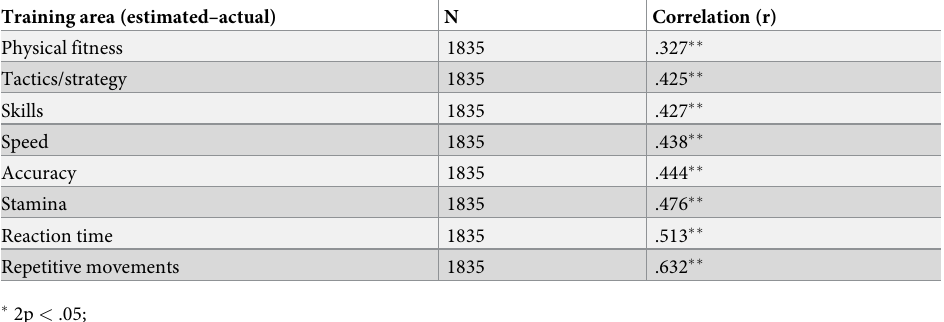
Table 22. Correlation between actual engagement and estimated importance of training areas.